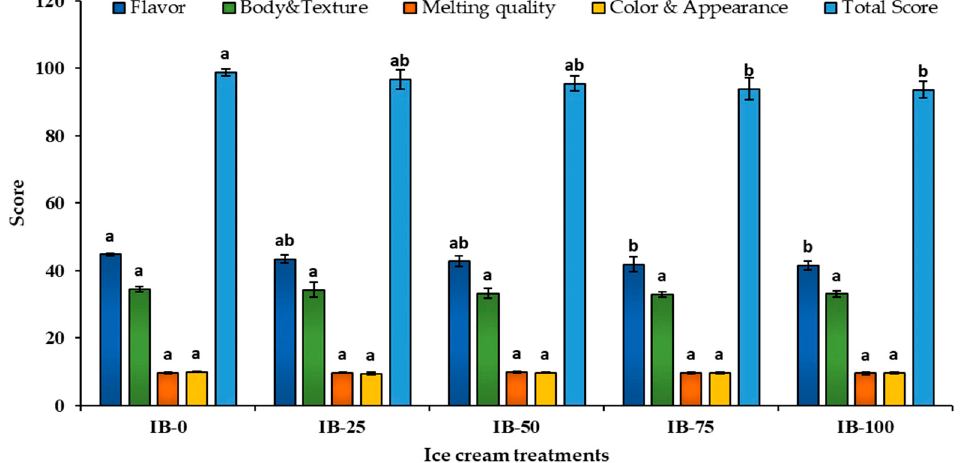
Figure 4. Organoleptic attributes scores of ice cream incorporating ADFP. IB-0: control ice cream, IB-25: ice cream with 25% of its skimmed milk content partially replaced with ADFP, IB-50: ice cream with 50% of its skimmed milk content partially replaced with ADFP, IB-75: ice cream with 75% of its skimmed milk content partially replaced with ADFP, IB-100: ice cream with its skimmed milk content replaced with ADFP. a,b : Bars not sharing similar letters are statistically different at p < 0.05.